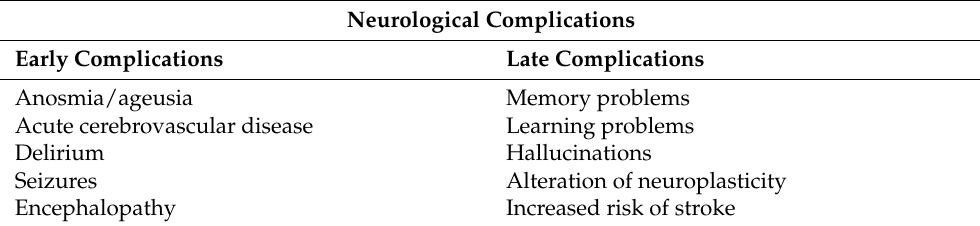
Table 1. Immediate and late neurological complications reported in COVID-19 studies. (REFERENCE: elaborated by the authors, based on Stiller et al. [26], Madani Neishaboori [28], Boscutti et al. [33], Maury et al. [34], and Fotuhi et al.